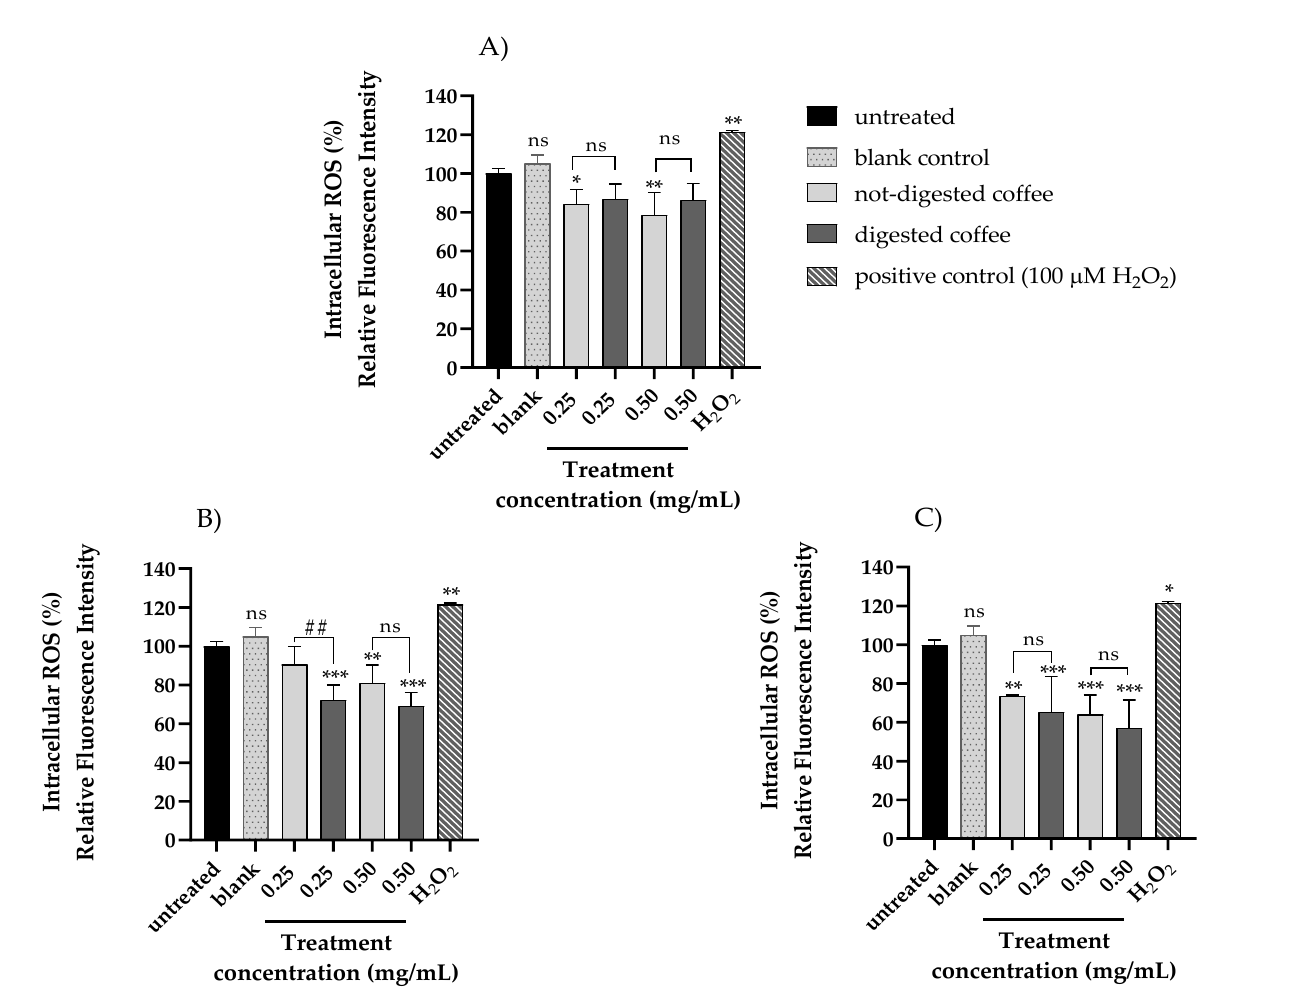
Figure 2. Evaluation of intracellular ROS level in HT-29 cells treated with not-digested or digested coffee samples. Intracellular ROS level was assessed by H 2 DCF-DA assay on HT-29 cells treated for 24 h ( A ), 48 h ( B ), and 72 h ( C ) with different concentrations of digested and not-digested coffee samples (0.25 and 0.5 mg/mL) and with vehicle (blank control) resulting from in vitro digestion related to untreated cells. Cells treated with 100 µ M H 2 O 2 were used as positive control. Mean ± SD of three independent experiments were plotted on the graph. Differences were considered significant when p -value ≤ 0.05 and p -value ≤ 0.01 and highly significant when p -value ≤ 0.001. * p ≤ 0.05, ** p ≤ 0.01, and *** p ≤ 0.001 versus untreated control (calculated as fold-change relative to untreated cells, arbitrarily set at 100%); # p ≤ 0.05, ## p ≤ 0.01, and ### p ≤ 0.001 not-digested coffee versus digested coffee. No significant differences were observed between blank control and untreated cells at 24 h, 48 h, and 72 h. ns: not statistically significant.